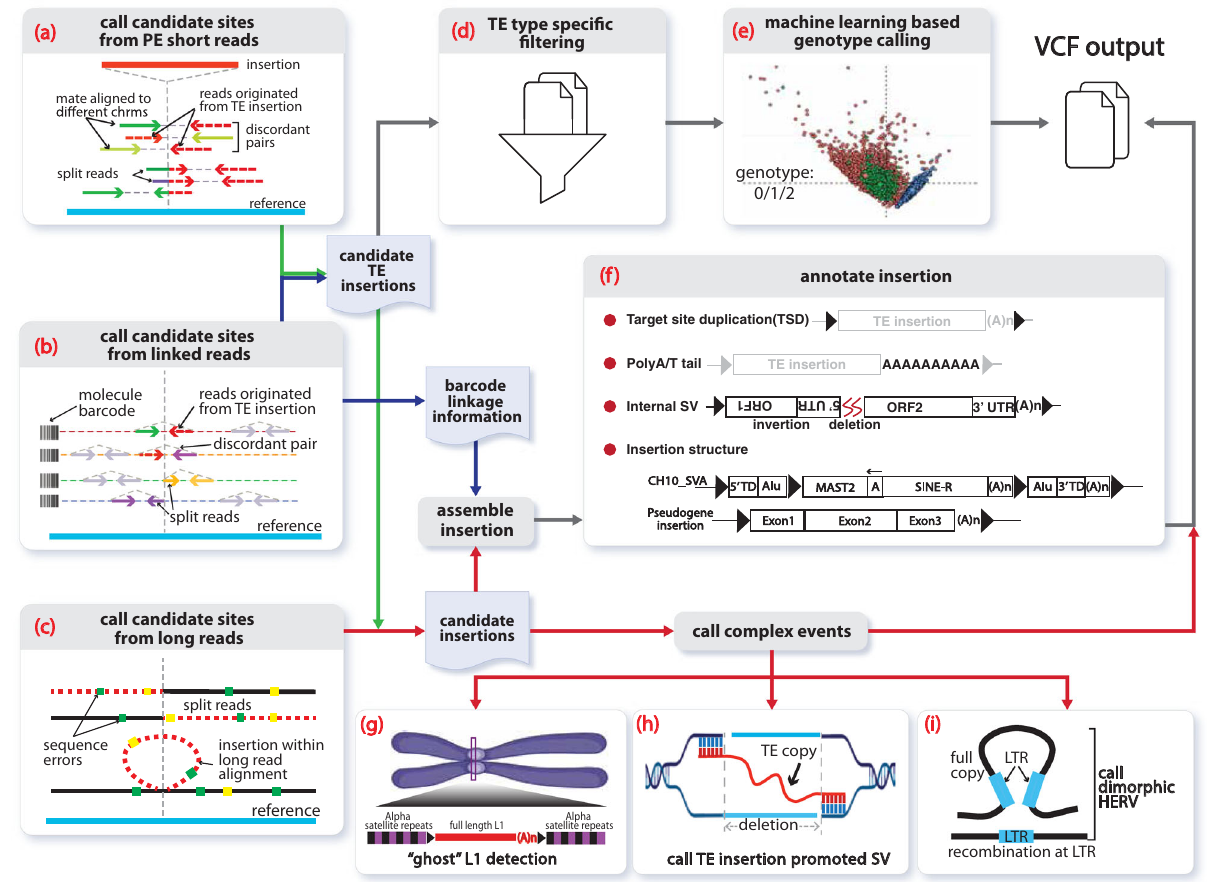
Fig. 1 Overview of TE analysis using xTea. First, xTea identi fi es candidate insertion sites from three possible sets of data (or a hybrid): a paired-end Illumina short reads. b 10X Linked Reads, or c long reads. d Second, xTea fi lters candidate sites called from short reads for each speci fi c transposable element (TE) type. e Third, for identi fi ed TE insertions, xTea uses a machine learning-based approach to call genotypes from short reads. f Fourth and fi nally, xTea annotates TE insertions and other retroelement insertions. g A schematic of a ‘ ghost ’ full-length L1 insertion detected from the centromere. h xTea can identify TE insertions that promote structural variation (SV) formation. i xTea can also identify dimorphic HERVs with given reference LTR Fig. S4 – S5) that were present in HG002 but absent in the